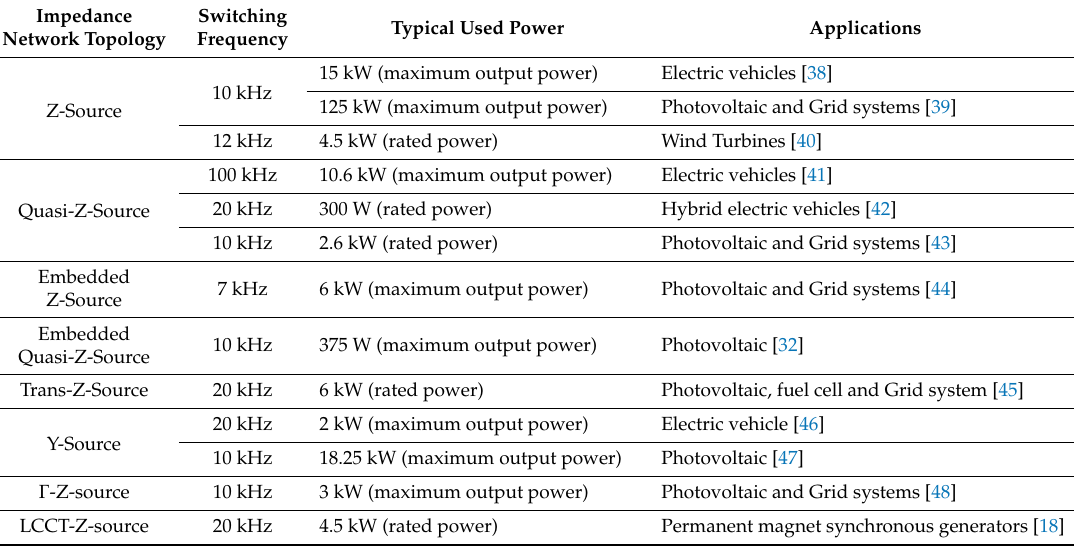
Table 3. Summary of the impedance source inverter applications with typical used power.